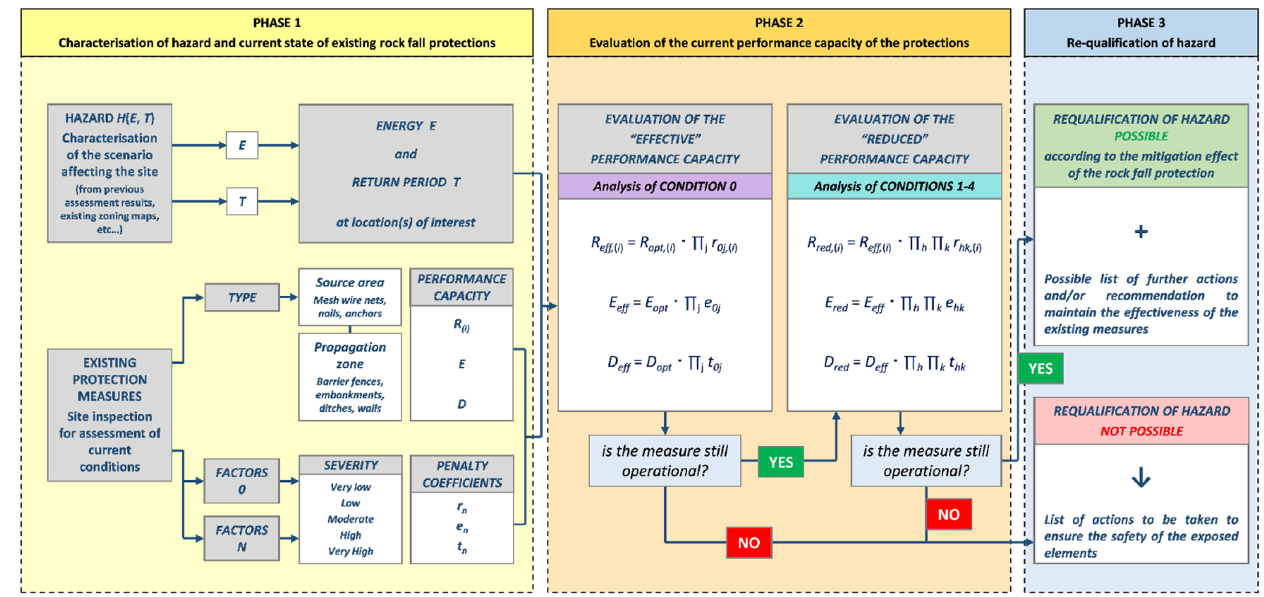
Figure 1. Scheme of the methodological framework for evaluating the effectiveness of rock fall pro- tections.